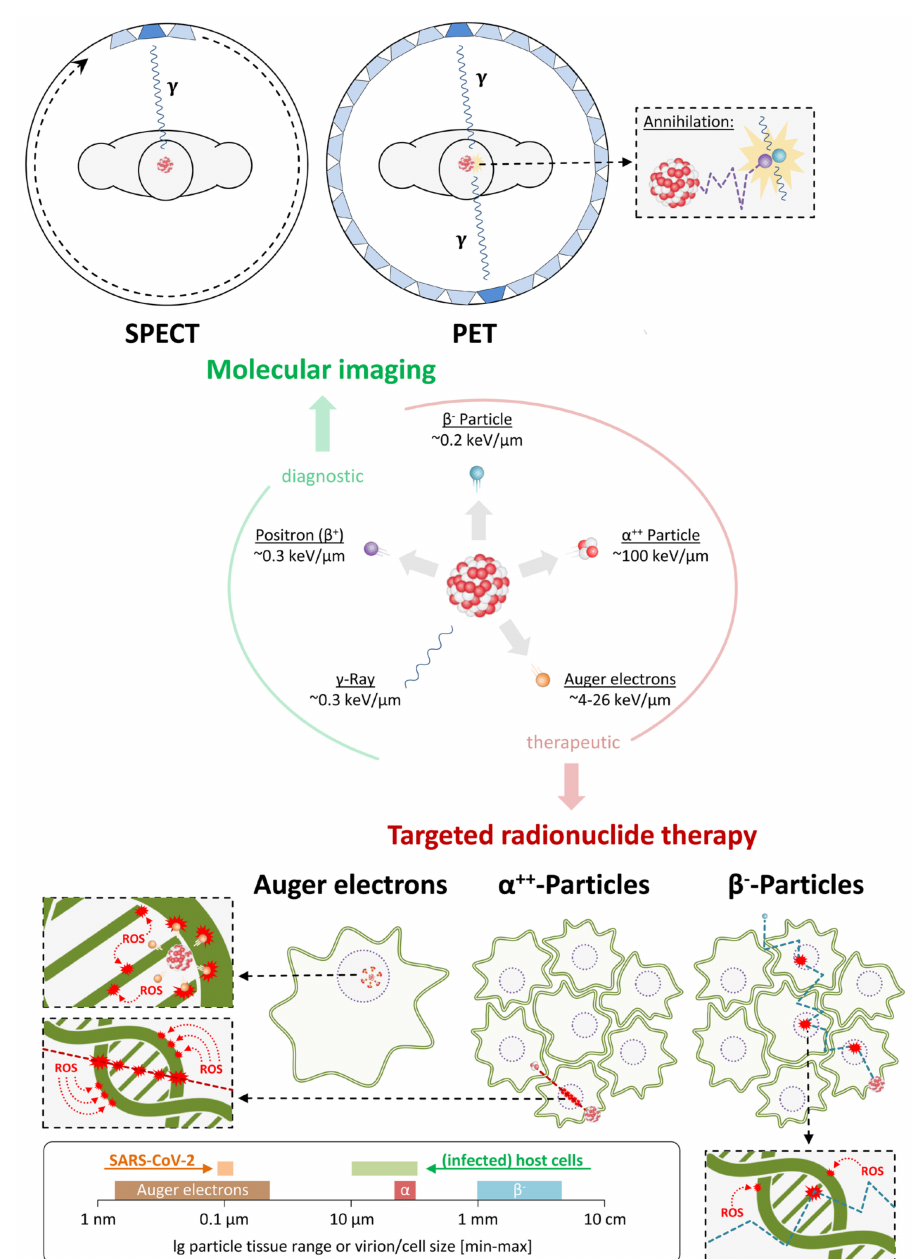
Figure 10. Overview of diagnostic and therapeutic nuclear medicine techniques. Shown are di ff erent types of radiation and their approximate linear energy transfer ( middle ) as well as their use for molecular imaging by PET and SPECT ( top ) or for targeted radionuclide therapy ( bottom ). Inset in the bottom left compares the tissue range of particles emitted by di ff erent types of therapeutic radionuclides with the size of SARS-CoV-2 virions and (infected) host